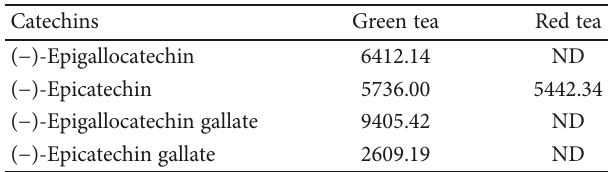
Table 1: Concentration of catechins (mg/ml) found in samples of the two teas from Camellia